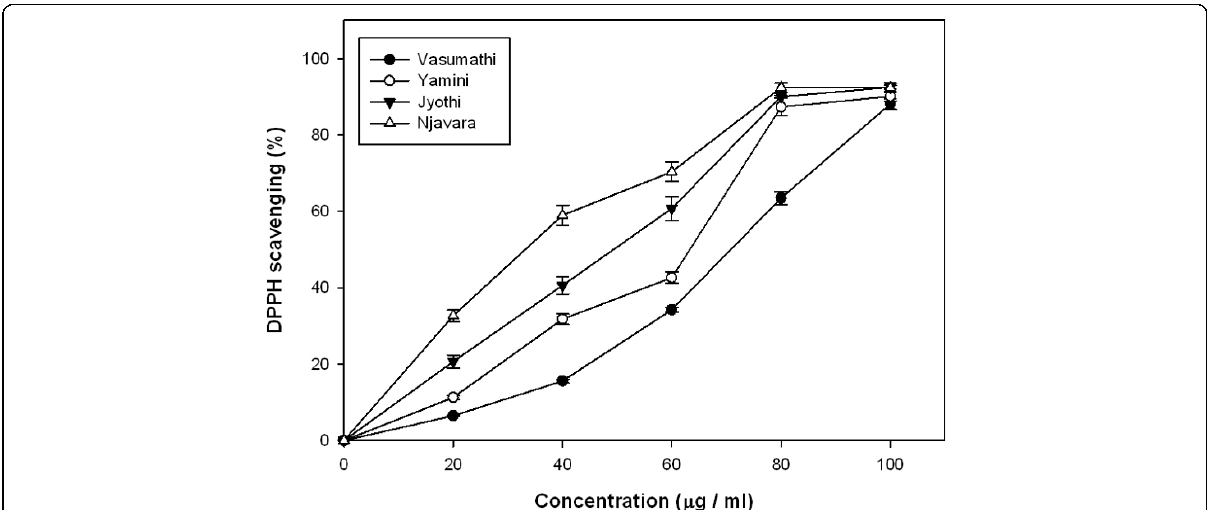
Figure 3 DPPH radical scavenging activity (%) . DPPH scavenging activity of different concentrations of methanolic rice bran extracts from four rice varieties. Results represent means ± standard deviation (n =